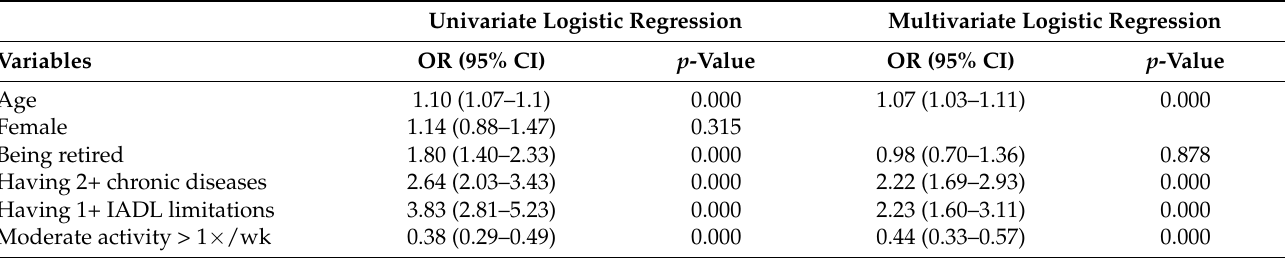
Table 2. Predictors for obesity coexisting with low handgrip strength, analysed with univariate and multivariate binary logistic regression analysis.